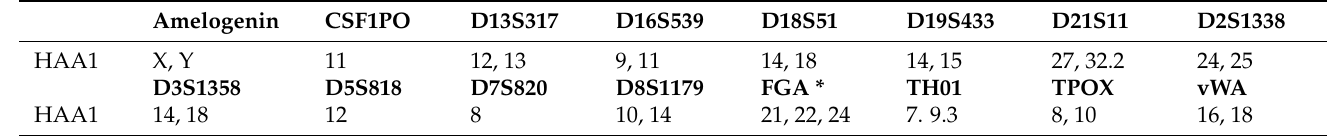
Table 2. Short tandem repeat profile of